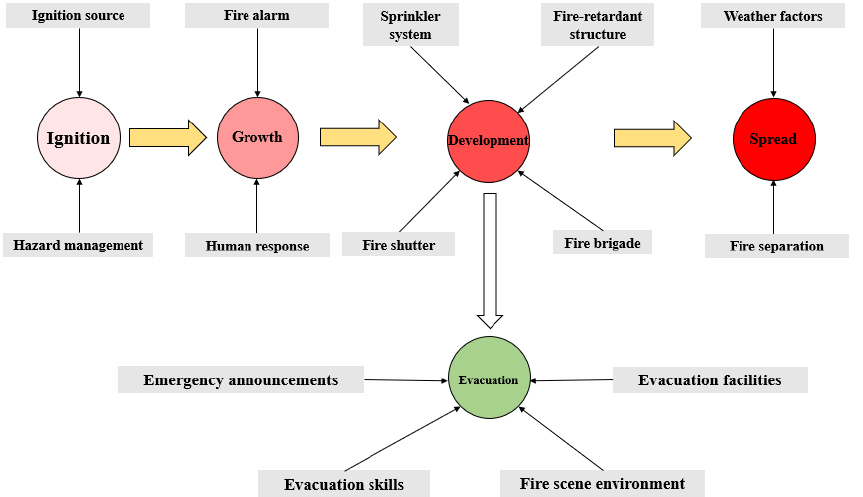
Figure 2. Conceptual framework for fire risk assessment based on BN.